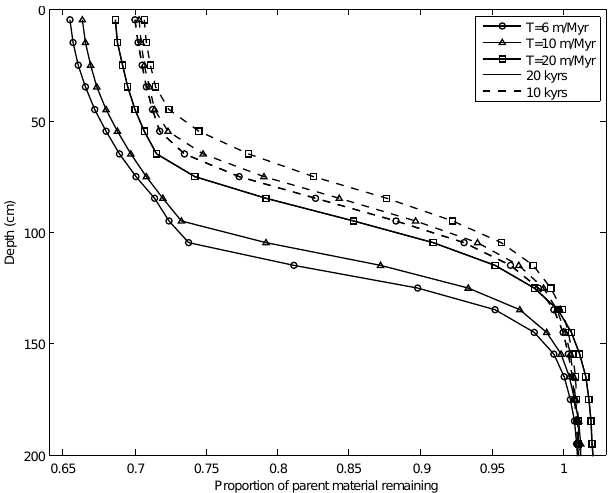
Figure 4. Proportion of original parent material remaining after 10 and 20kyrs of model simulation for 3 different rates of surface ero- sion ( T